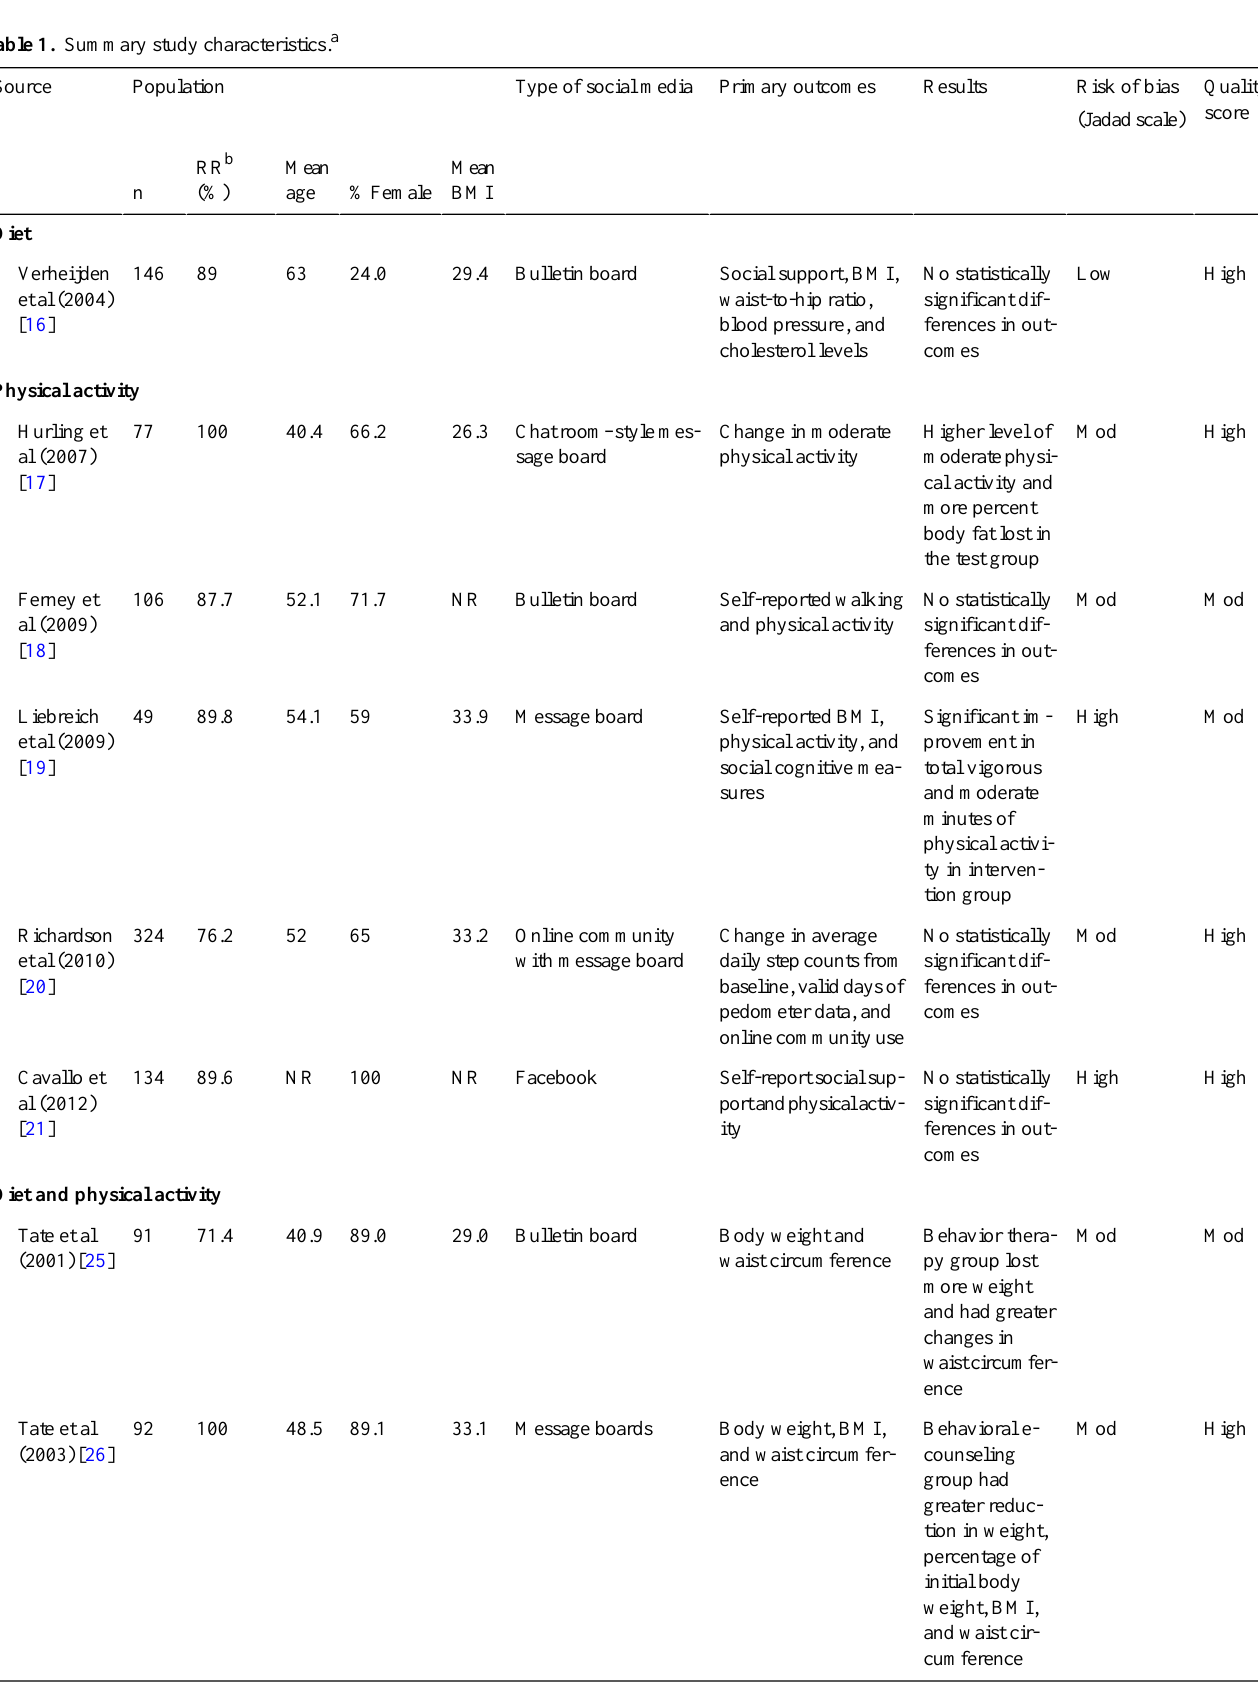
Table 1. Summary study characteristics. a